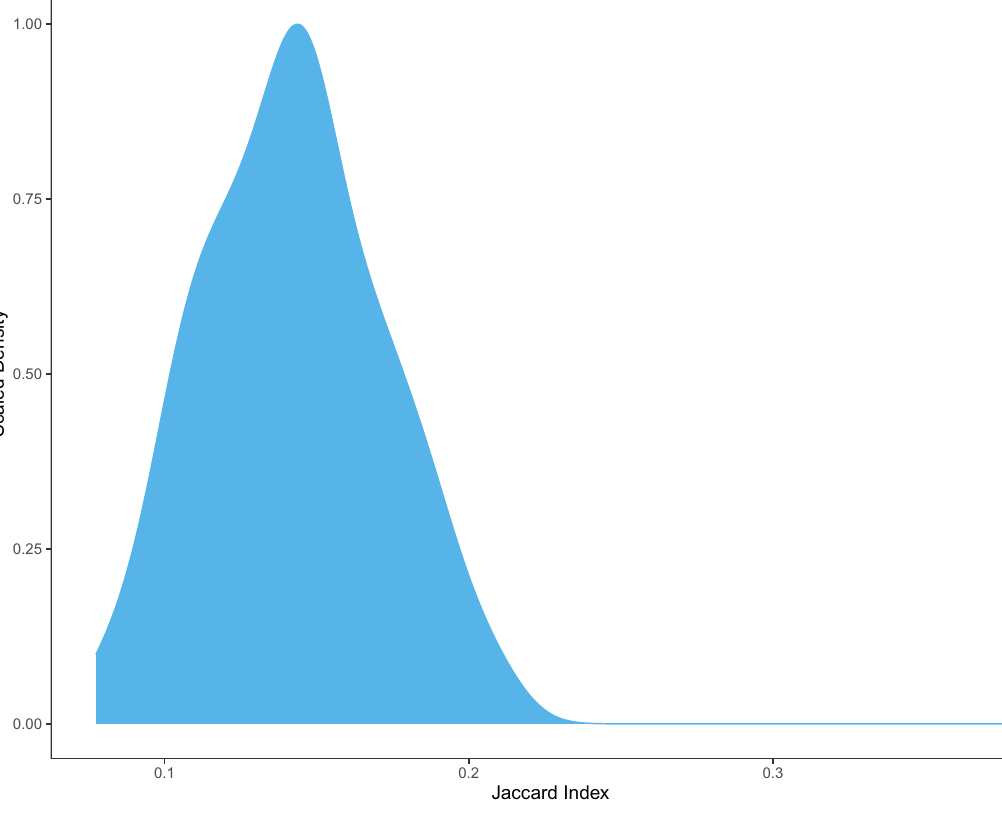
Figure 3. Scaled density of Jaccard index measures of the overlap in heterozygous sites in the two offspring, showing that the degree of overlap in the empirical dataset (in gold) is nonrandom and significantly greater than expected based on measures from 100 randomly permutated datasets (in